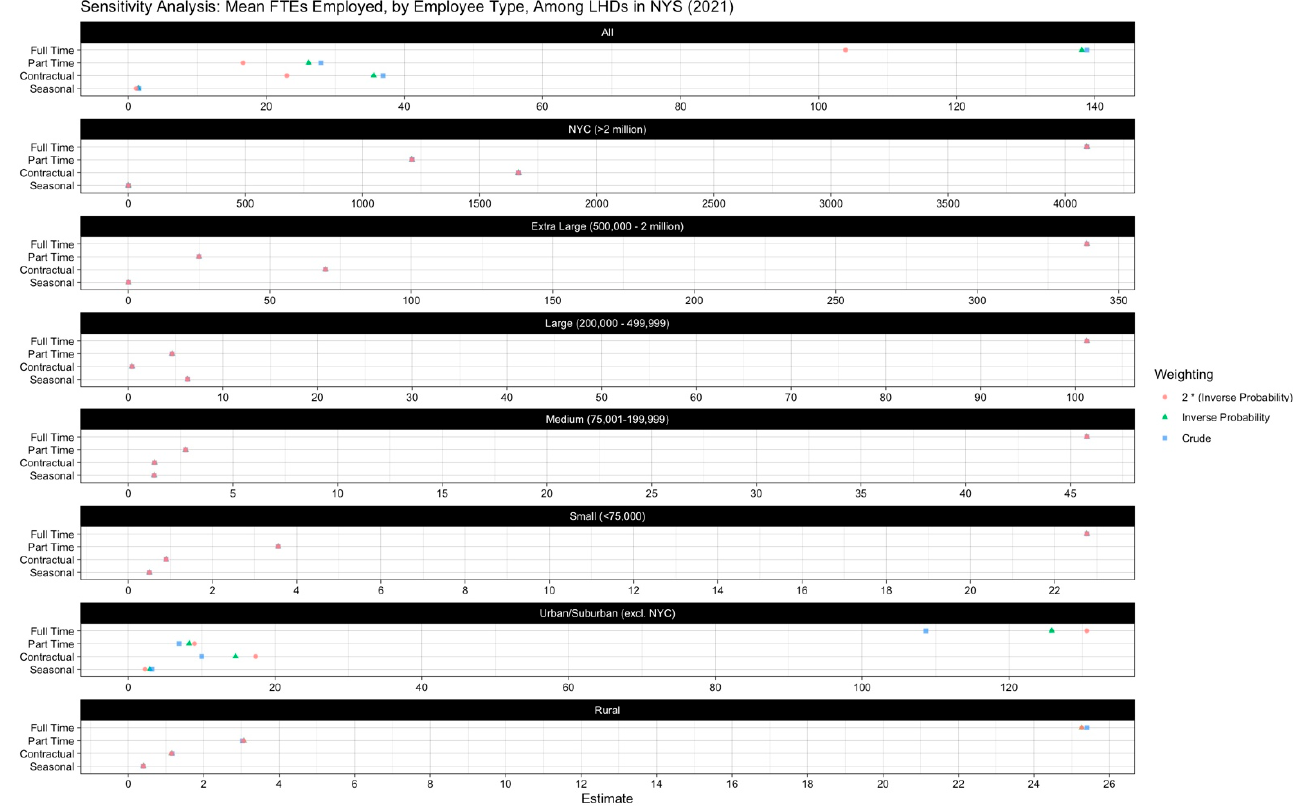
Figure A1. Sensitivity Analysis for Table 2.